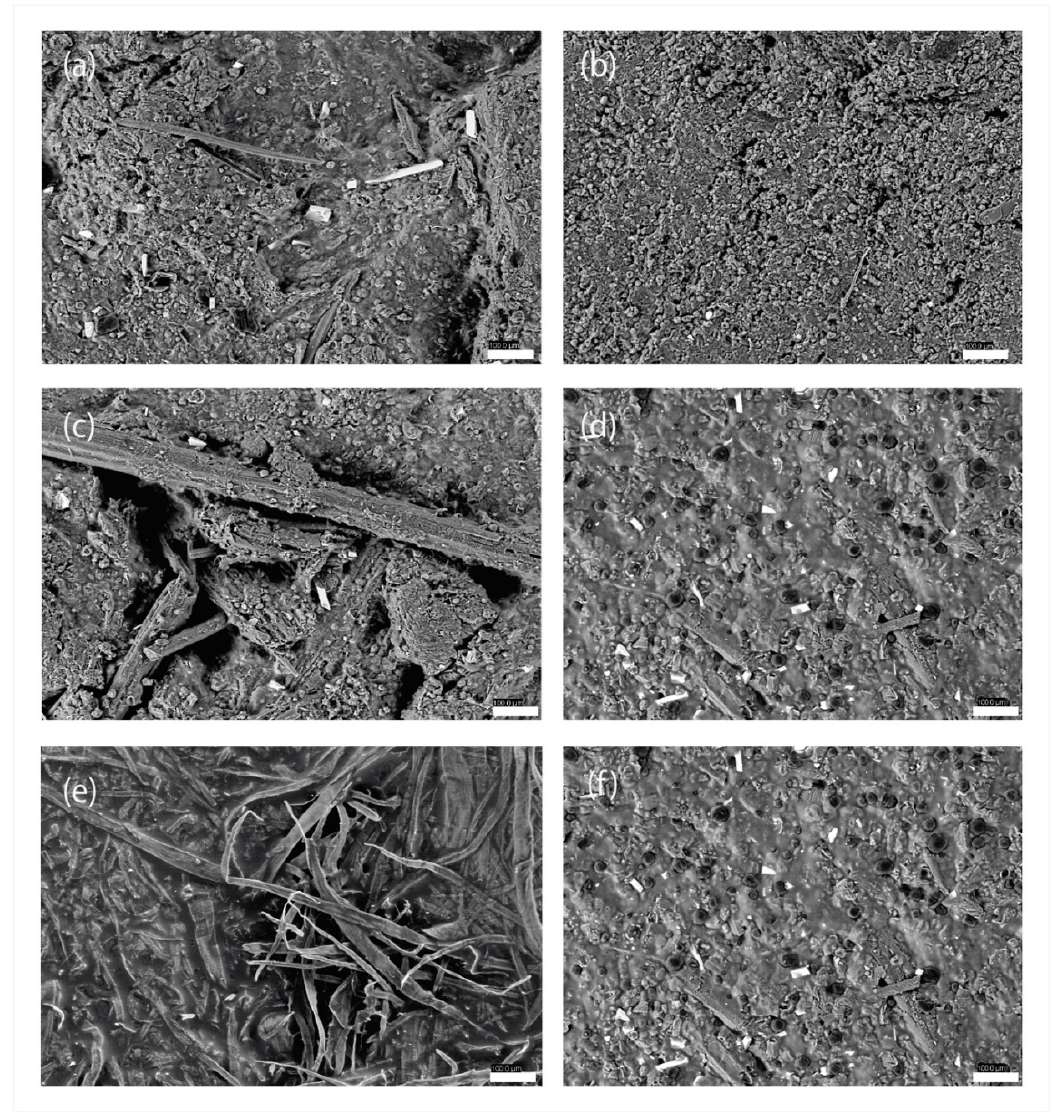
Figure 4. Scanning Electron Microscope (SEM) images of LBMs ( a ) FL30, ( b ) FC30, ( c ) FL50, ( d ) FC50, ( e ) FL70, and ( f ) FC70. The bar corresponds to 100 µm, 60× magnification.